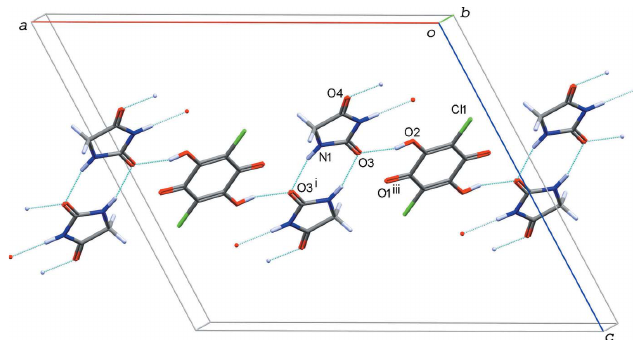
Figure 5 A partial packing diagram of compound (II), showing hydrogen-bonding scheme in the layer formed by base molecules. N—H (cid:2)(cid:2)(cid:2) O hydrogen bonds between the base molecules are shown by light-blue dotted lines, while O—H (cid:2)(cid:2)(cid:2) O hydrogen bonds between the base and acid molecules are shown by red dotted lines. [Symmetry codes: (i) (cid:4) x + 1, (cid:4) y + 1, (cid:4) z + 1; (ii) (cid:4) x + 1 , y + 1 , (cid:4) z + 1 ; (iv) (cid:4) x + 1 , y (cid:4) 1 , (cid:4) z + 1 2 2 2 2 2 2